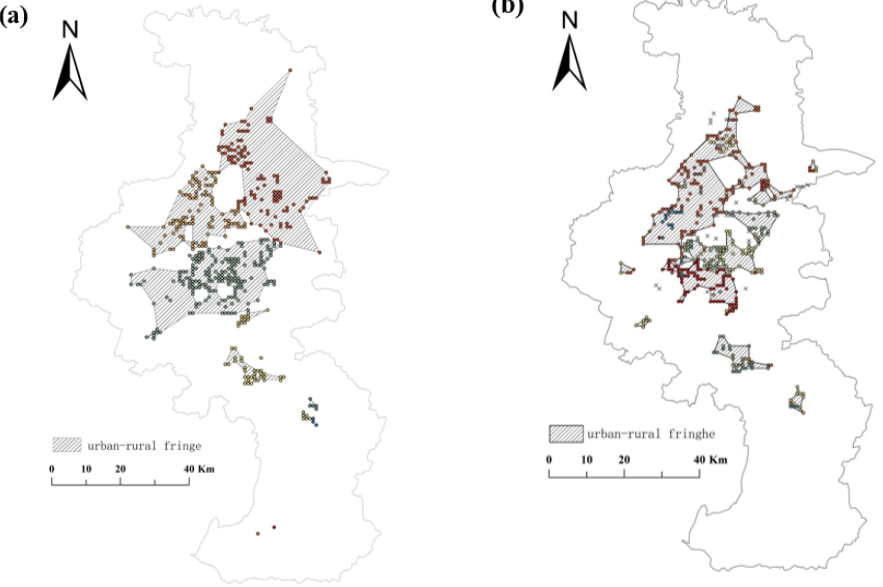
Figure 12. Detection of urban fringe with different dual spatial clustering methods: ( a ) Mk-means clustering (k = 10); ( b ) DBSC clustering. Table 2. The clustering results from statistical information.